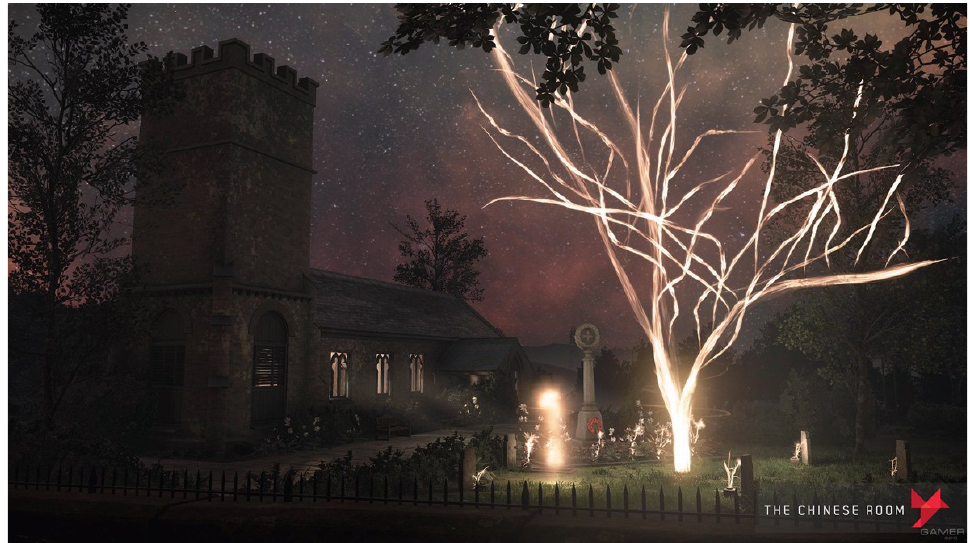
Figure 1. Pattern dancing in front of the